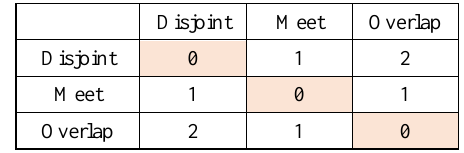
Table 1 The matrix for indexing topological transition step for calculating 𝑑 1 and 𝑑